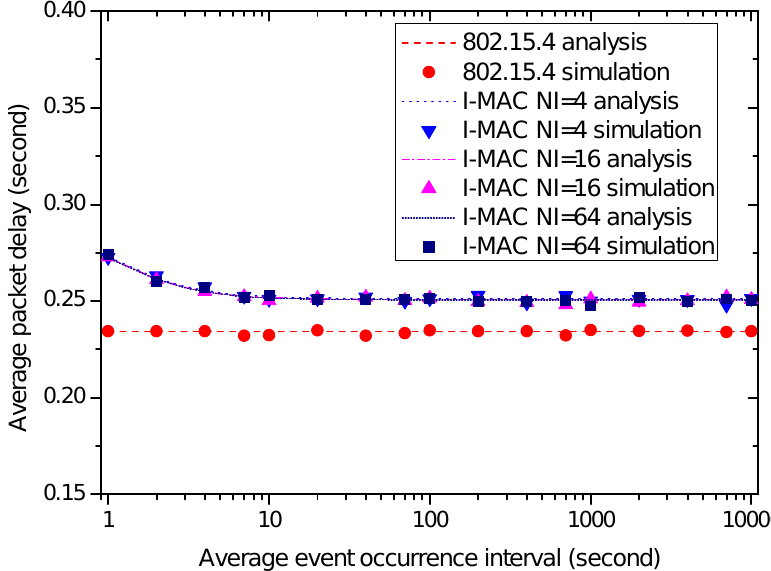
Figure 16. The effect of the average event occurrence interval on average packet